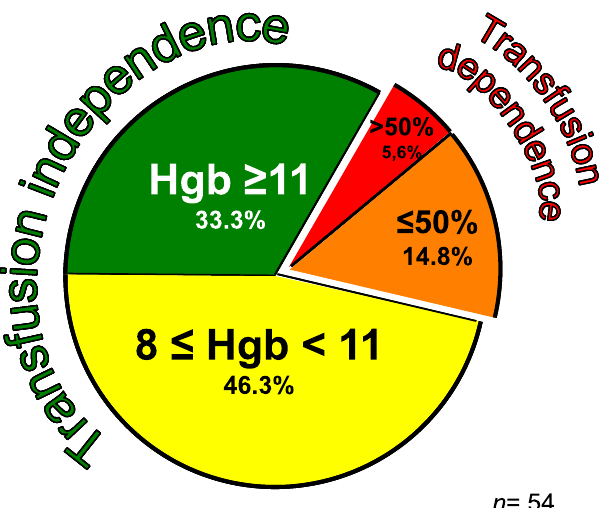
Figure 1. Variable hematological response to eculizumab treatment (modified from